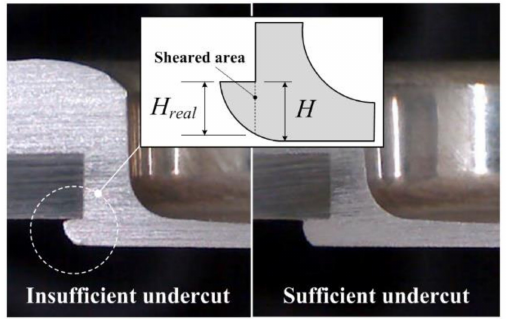
Figure 9. Effects of process parameters on the geometrical interlocking parameters.